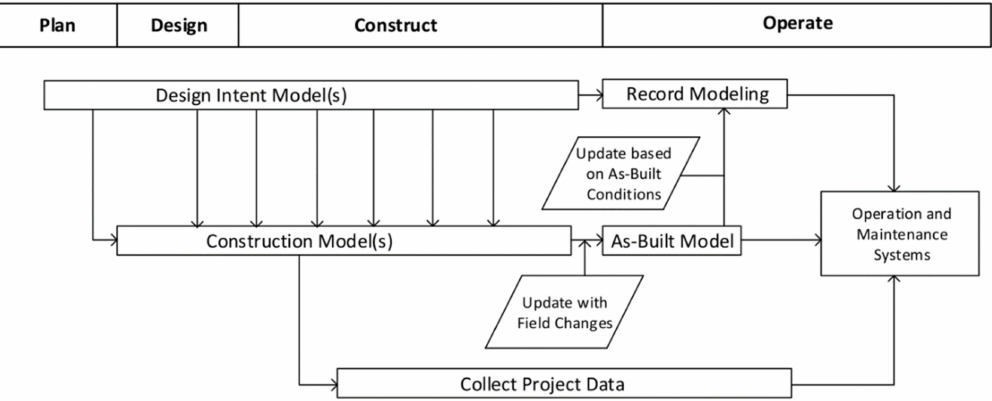
Figure 2. Typical information flow map for a BIM-enabled asset information delivery process proposed by